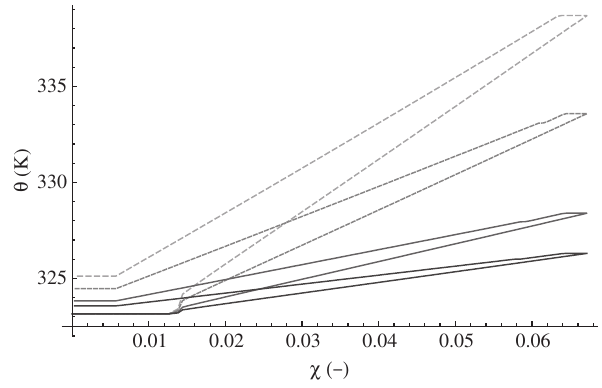
Figure 1 Temperature over strain with varying heat conductivity κ ∈ {0.010, 0.015, 0.030, 0.050} GPa/K. Higher temperature evolu- tion is observed at lower values of κ